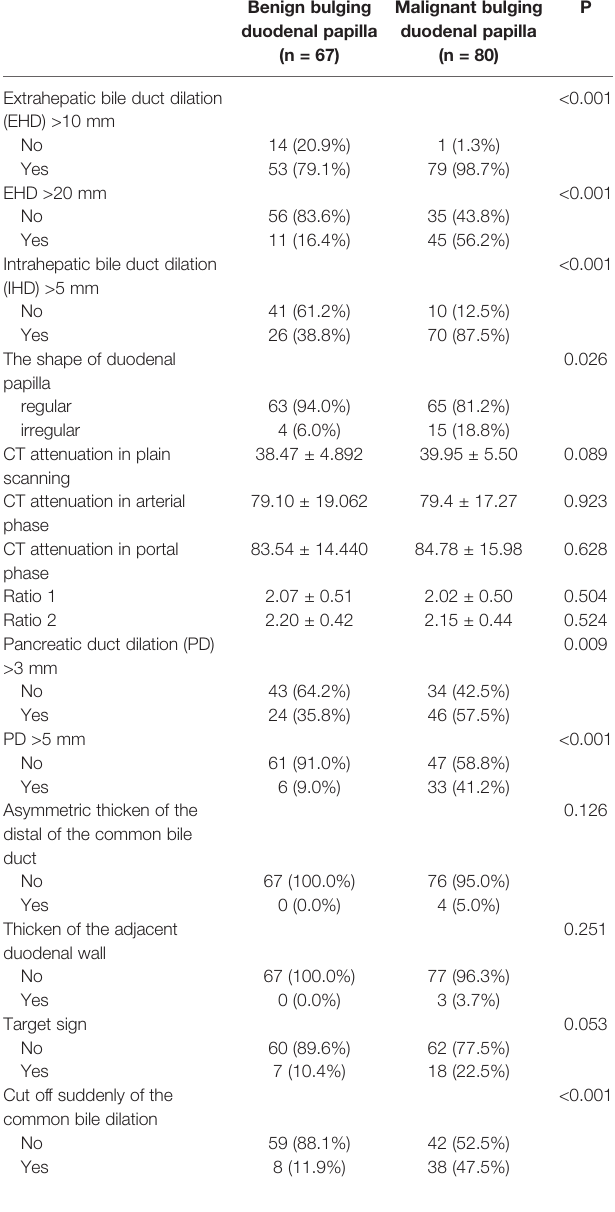
TABLE 2 | Imaging features in patients.